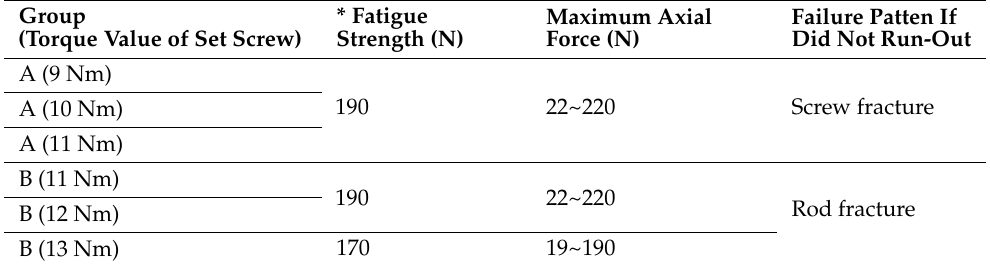
Table 4. Results of the dynamic compression bending test for two test